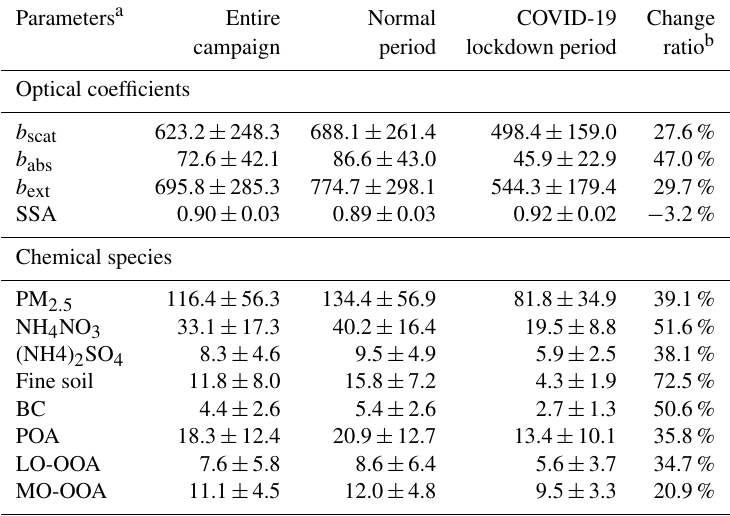
Parameters a Entire Normal COVID-19 Change campaign period lockdown period ratio b Optical